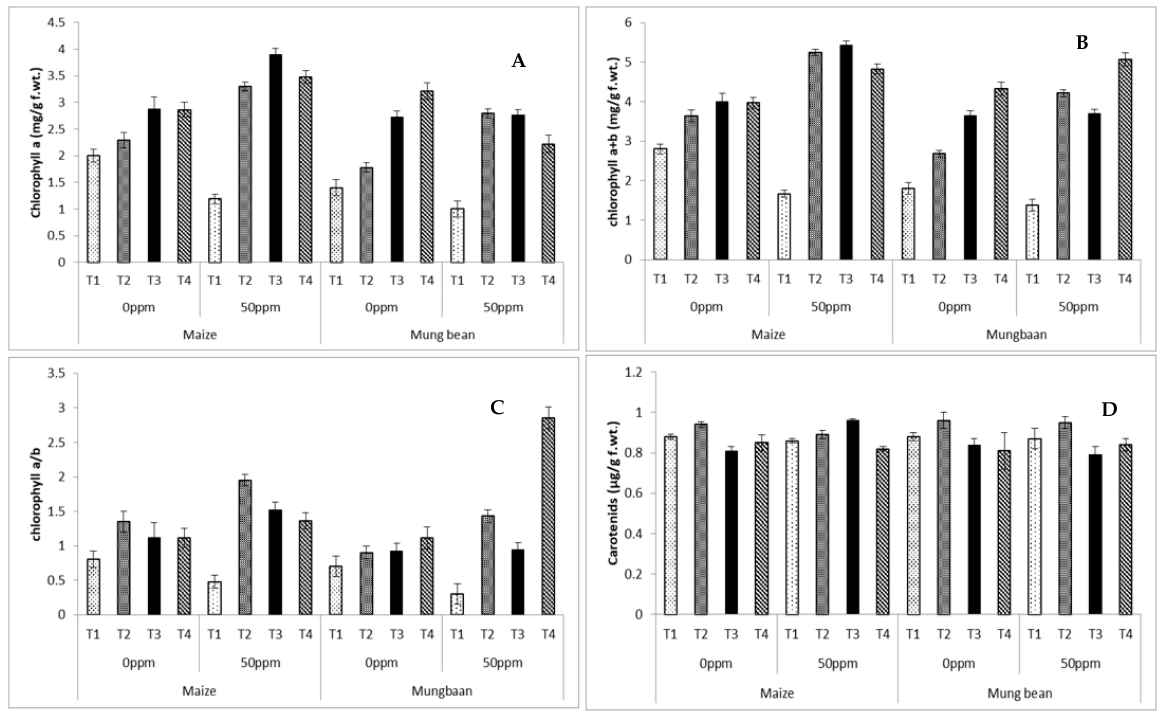
Figure 5. Photosynthetic pigments ( A ) chlorophyll a ( B ) chlorophyll a + b ( C ) chlorophyll a/b ( D ) carotenoids of maize ( Zea mays L.) and mung bean ( Vigna radiata L.) exogenously treated with different B. subtilis strains under chromium stress conditions (mean ± S.E.). Here T1 = Nutrient broth, T2 = Nutrient broth + parent B. subtilis , T3 = Nutrient broth + UV ‐ irradiated B. subtilis and T4 = Nutrient broth + γ‐ irradiated B. subtilis .